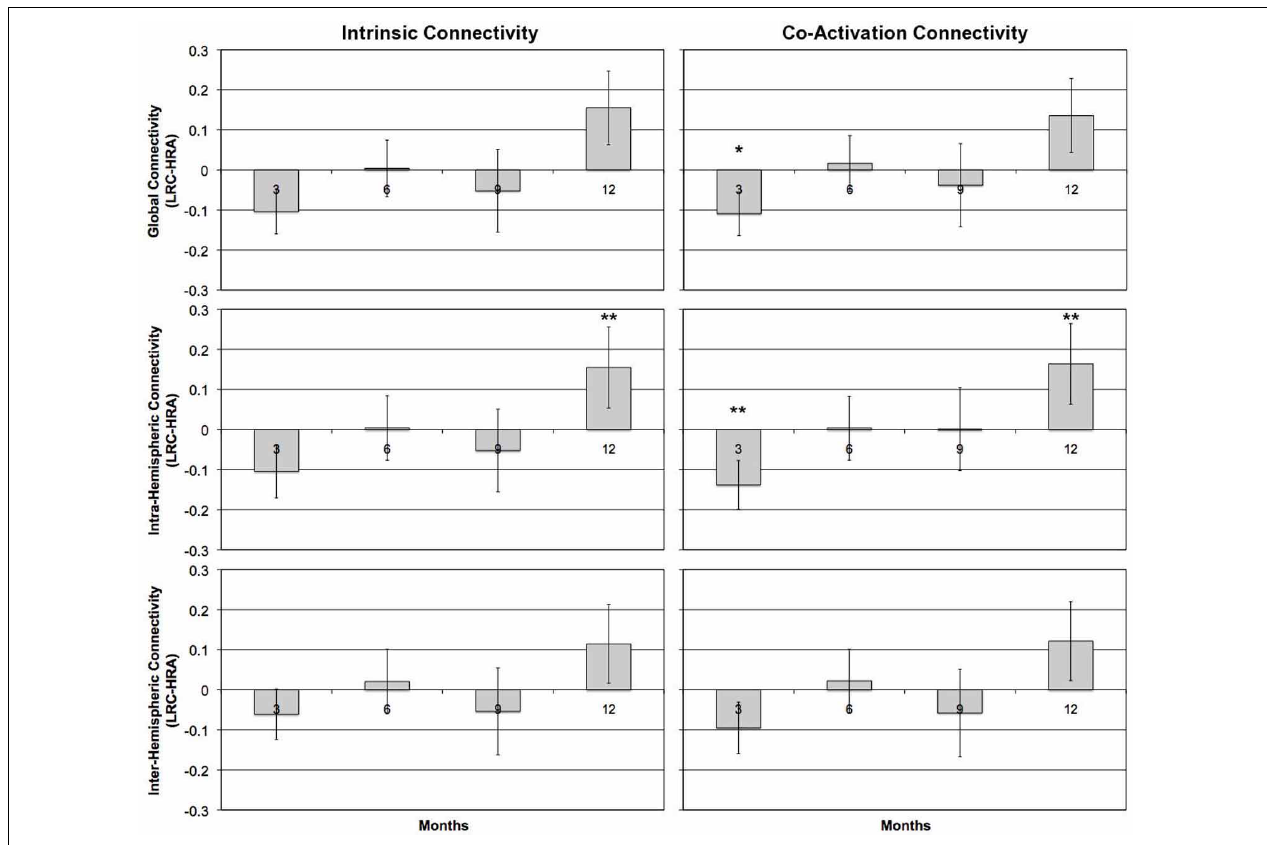
FIGURE 4 | Group differences in mean z ’-scores for global connectivity and intra- and inter-hemispheric connectivity measures at 3-, 6-, 9-, and 12-months for task-regressed, intrinsic functional (left column) and